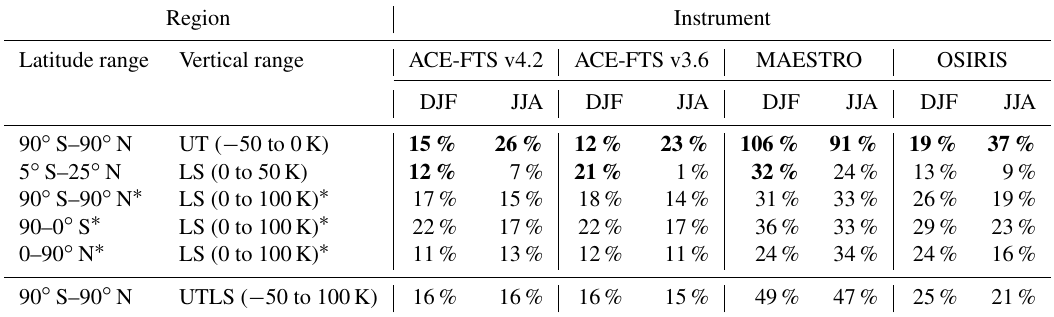
Table 2. As in Table 1 but for ozone and with additional columns for the OSIRIS comparisons. Note that the regions marked with an asterisk (*) exclude the span from 5 ◦ S–25 ◦ N and 0–50K. Region Instrument Latitude range Vertical range ACE-FTS v4.2 ACE-FTS v3.6 MAESTRO OSIRIS